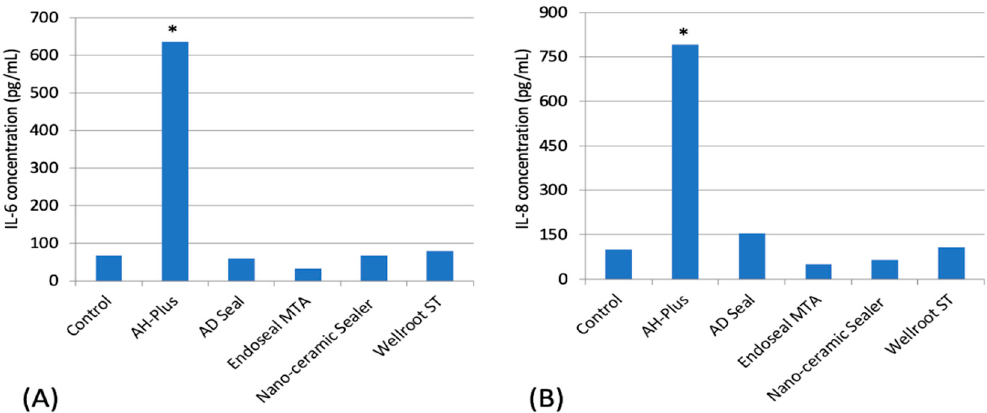
Figure 5. The e ff ects of sealers on the expression of pro-inflammatory cytokines ( A ) IL-6 and ( B ) IL-8 in hPDLSCs (* means significant di ff erence between groups connected by bar. p < 0.05).